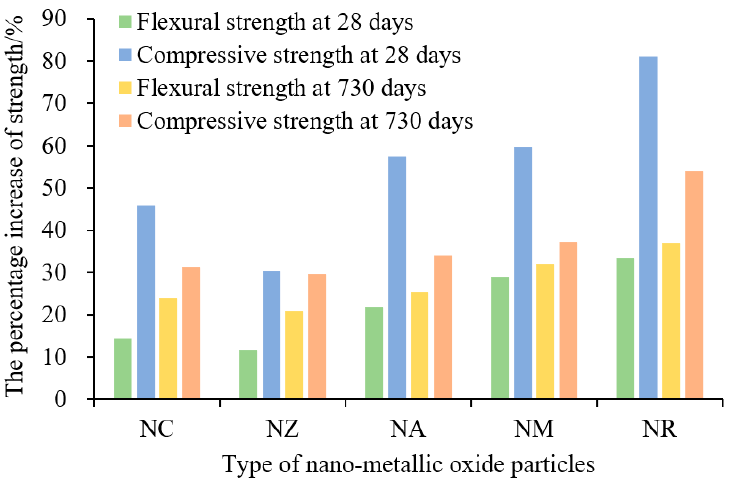
Figure 4. The percentage increase of strength at 28 and 730 days.